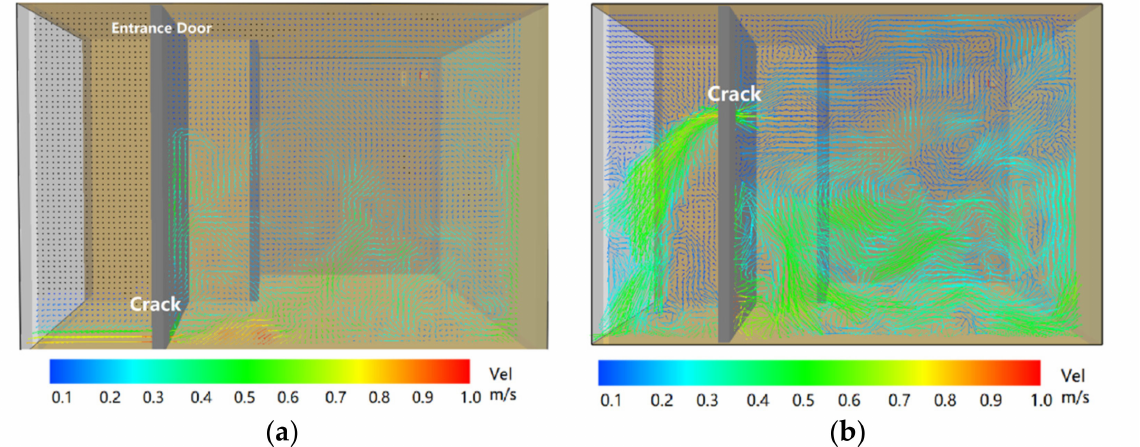
Figure 7. The velocity on the slice that crosses the entrance door after 60 s discharge for simulation case ( a ) T2_bottom and ( b ) T2_top.